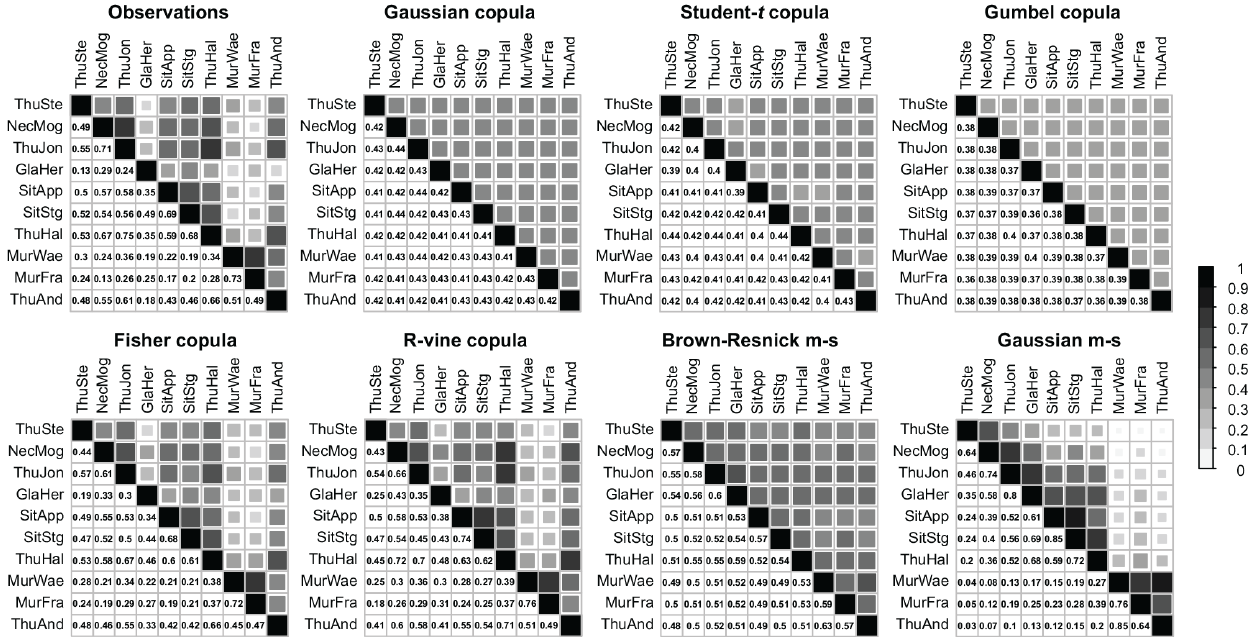
Figure 8. Kendall’s tau matrices for the observations and the event samples generated by different types of dependence models. The darker the color, the stronger the dependence.